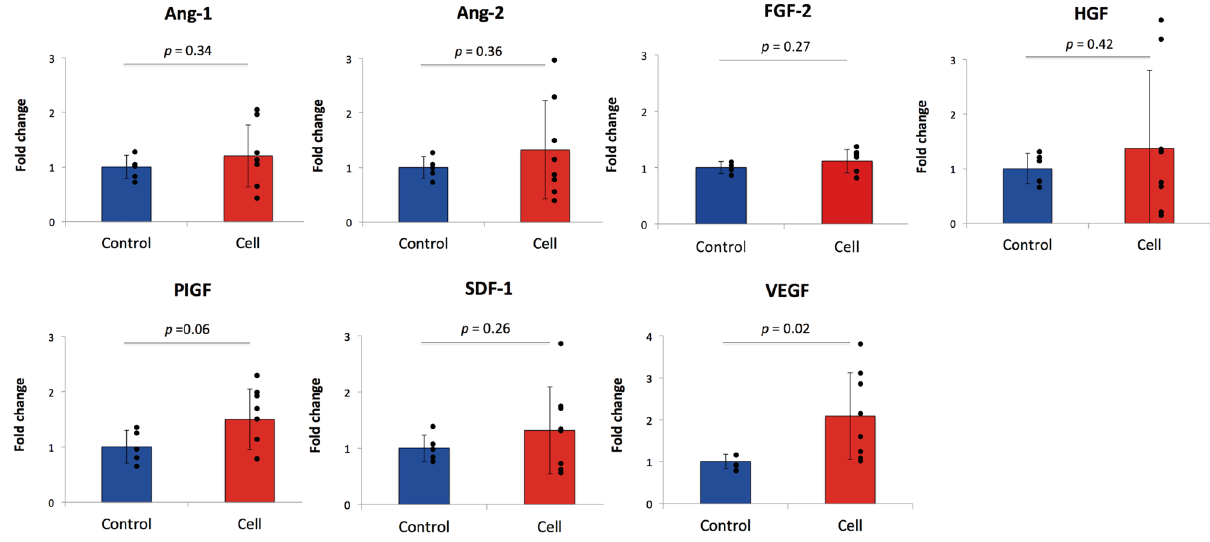
Figure 4. qPCR results of rat muscle tissues showing angiogenic factor gene expressions in the control and cell infusion